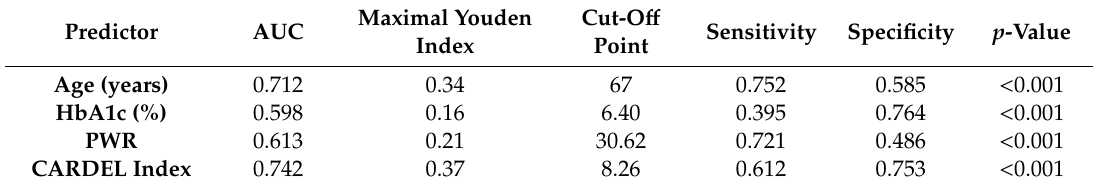
Table 8. Receiver operating characteristic (ROC) analysis for objective preoperative factors used to determine postoperative delirium after